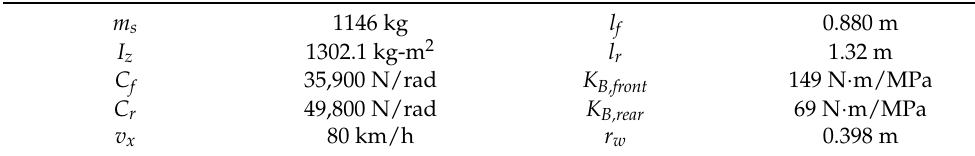
Table 1. Parameters of a sub–compact SUV model, listed in